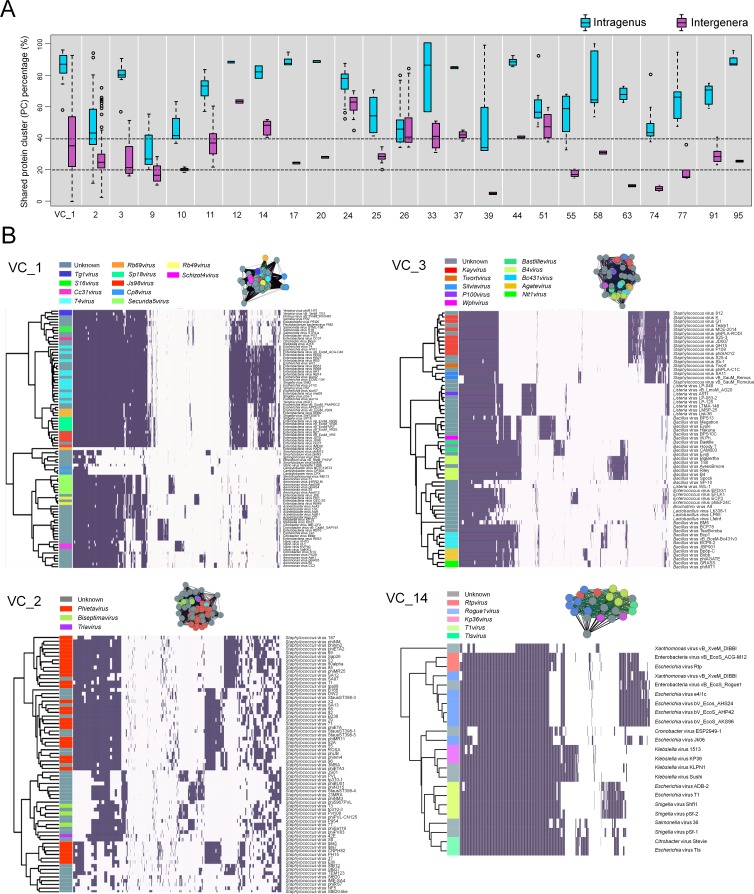
Heterogeneous VCs.Evaluation of VCs which contained taxon representatives from more than one ICTV genus. (A) Box plots show the percent inter- and intra-genus proteome similarities in the heterogeneous VCs. Dotted lines indicate the cut-off values of 20% and 40% proteome similarities to define the subfamily and genus, respectively, which have been ratified by the ICTV Bacterial and Archaeal Viruses Subcommittee. (B) Module profiles showing the presence and absence of PCs across genomes. Presence (dark box) denotes a gene that is present within a protein cluster. Genes from related genomes often cluster into the same PC, with alignments of highly related genomes showing large groups of PCs. Genomes are further partitioned using hierarchical clustering (see ‘Materials and Methods’).